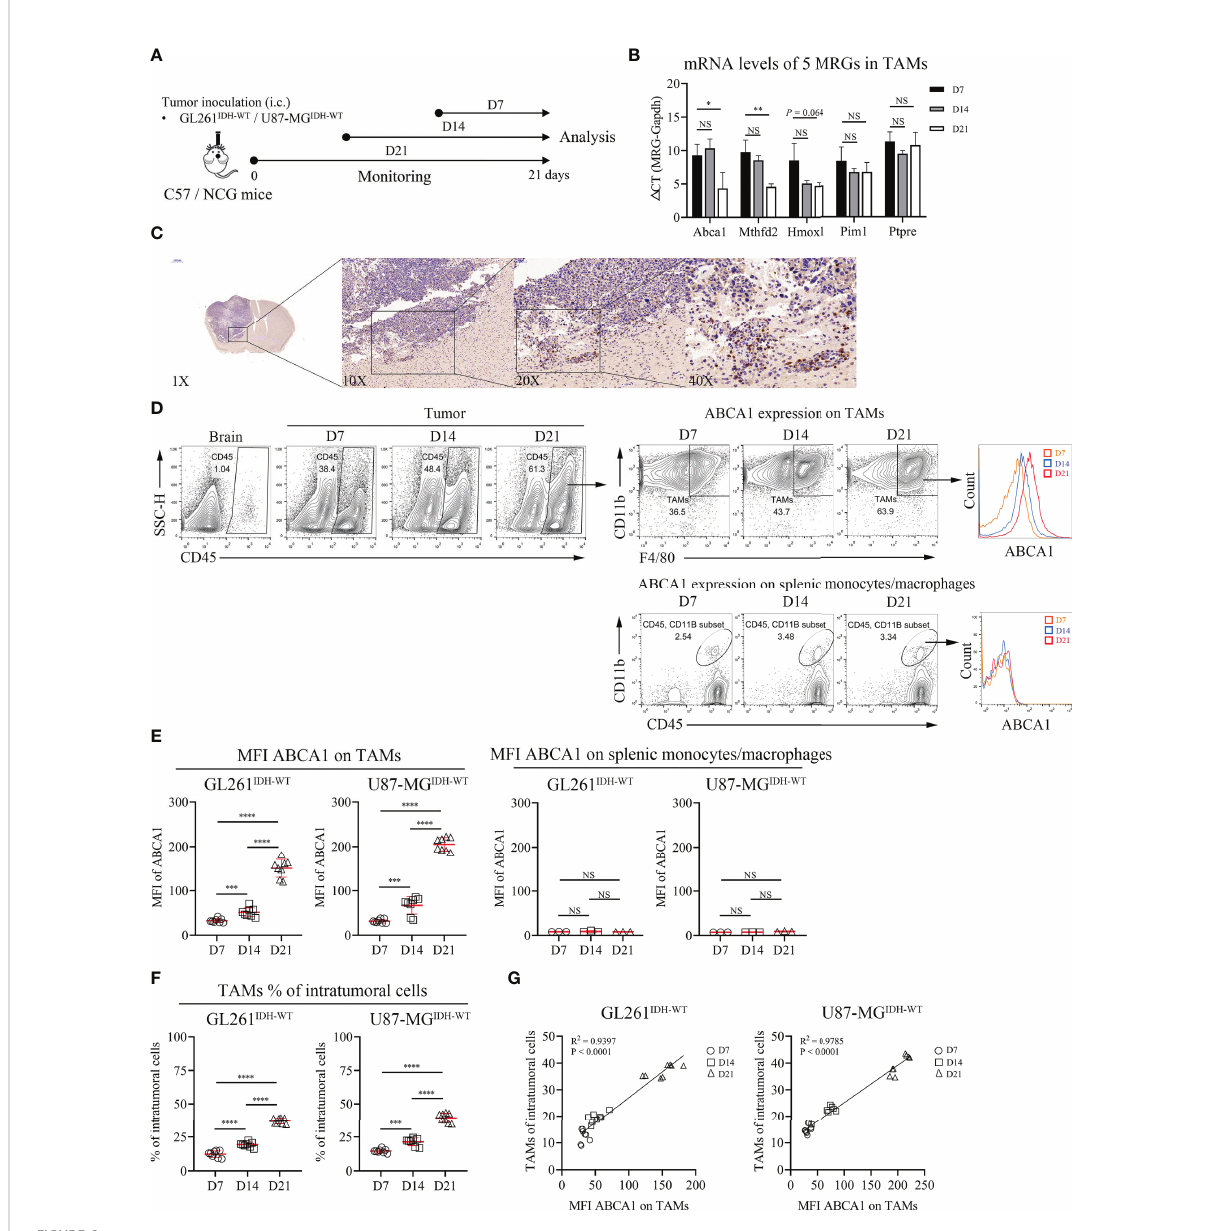
FIGURE 6 The Expression Level of ABCA1 in TAMs Positively Correlated with the Population ofTAMs with IDH WT GBM Tumor Progression. (A) Experimental setup to study the linksbetween MRGs expressionin macrophageandtumor progression. (B) Quantitative analysis ofmRNAexpressionlevels of5 MRGsin TAMs with tumorprogression. C57 micewereintracranially inoculated with GL261 cells. On day 7, day 14 and day 21, miceweresacri fi ced and collected tumor tissues. TAMs wereisolatedfromtumorsby anti-F4/80 microbeads and subjected to qPCR to detectmRNAexpression(n= 3). (C) Immunohistochemical analysis of the expressionlevels ofABCA1 in mouse tumor and normal brain tissue. (D, E) Representative fl ow cytometry plots (D) and quantitative analysis (E) ofTAMs and peripherally splenic monocytes/macrophage ABCA1 expression levels with tumor progression. Orthotopic tumors werecollected ondays 7, 14and21 after tumor inoculation. n = 8.f-g:Quantitative analysis of TAMpopulations (F) and pearson correlation analysis of TAMpopulations and TAMABCA1 expression levels (G) . Data is relatedto (D, E) . The difference between risk groups was calculated by the Mann – Whitney test (NS,nostatistical signi fi cance, * P < 0.05, ** P < 0.01, *** P < 0.001,**** P <